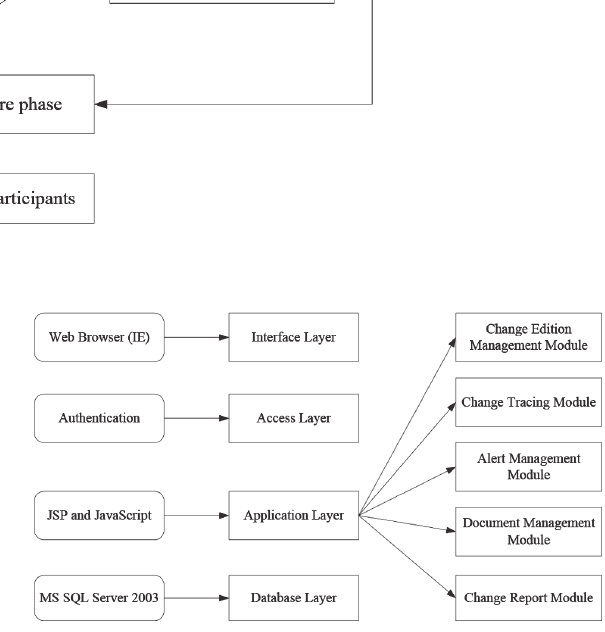
Fig. 4. WPCM system